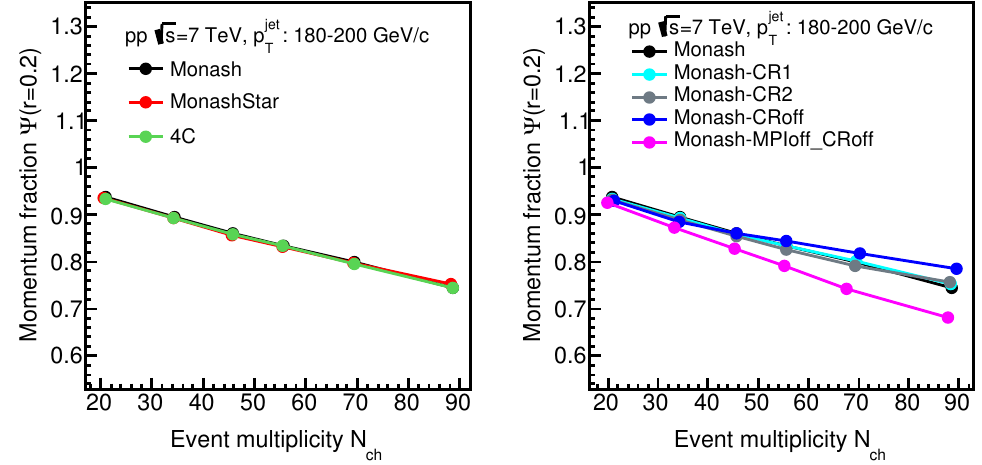
Figure 2. ( Left ) Integrated jet shape for different tunes; ( Right ) Integrated jet shape for different